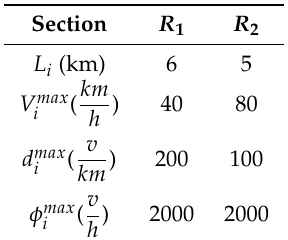
Table 1. Parameters of both sections R 1 et R 2